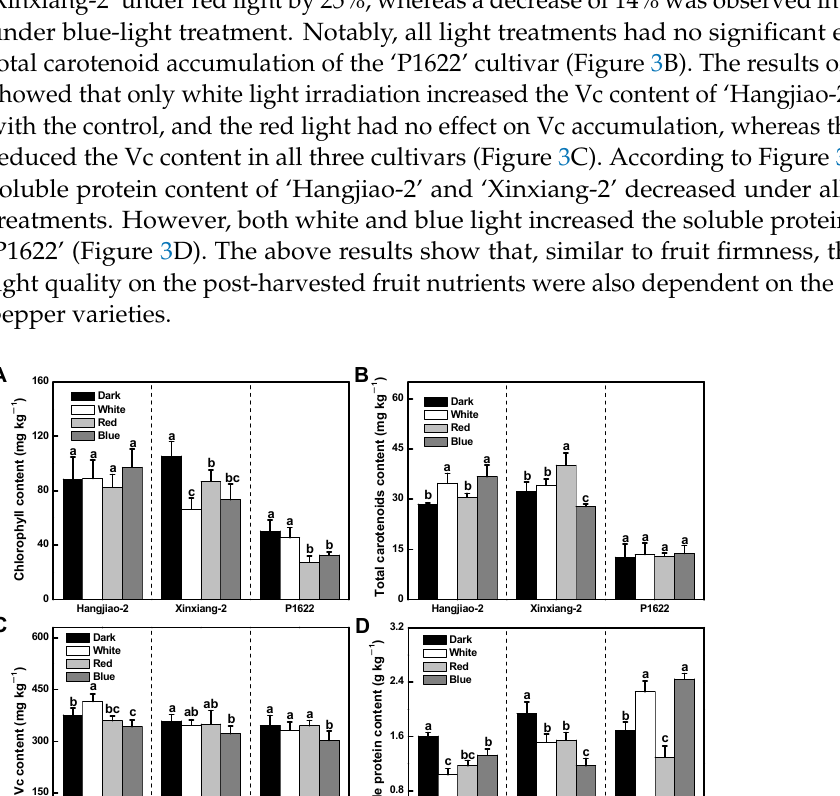
Figure 2. Effect of light quality on fruit firmness. Results are shown as mean ± SE of twelve samples.